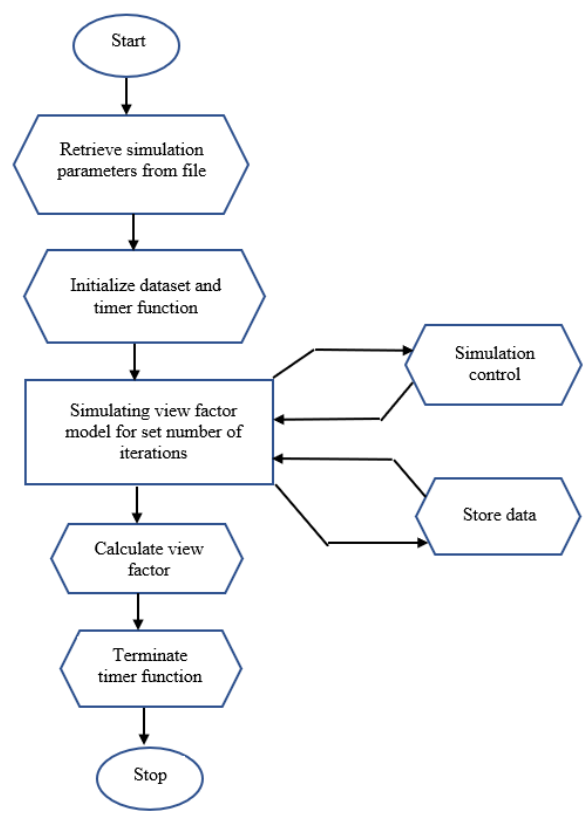
Figure 4. Flow chart of the simulation model .